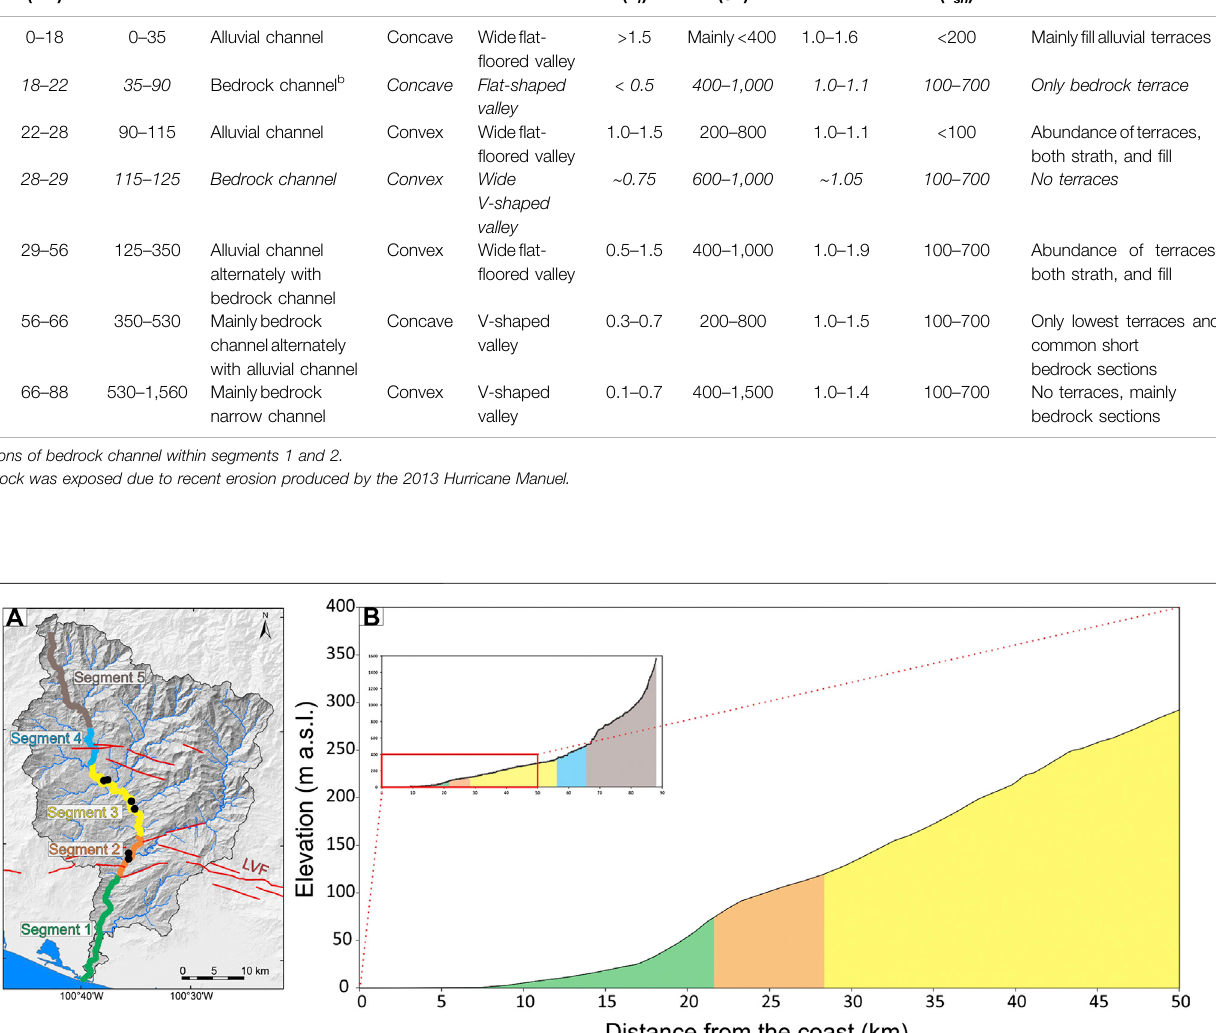
Frontiers in Earth Science |